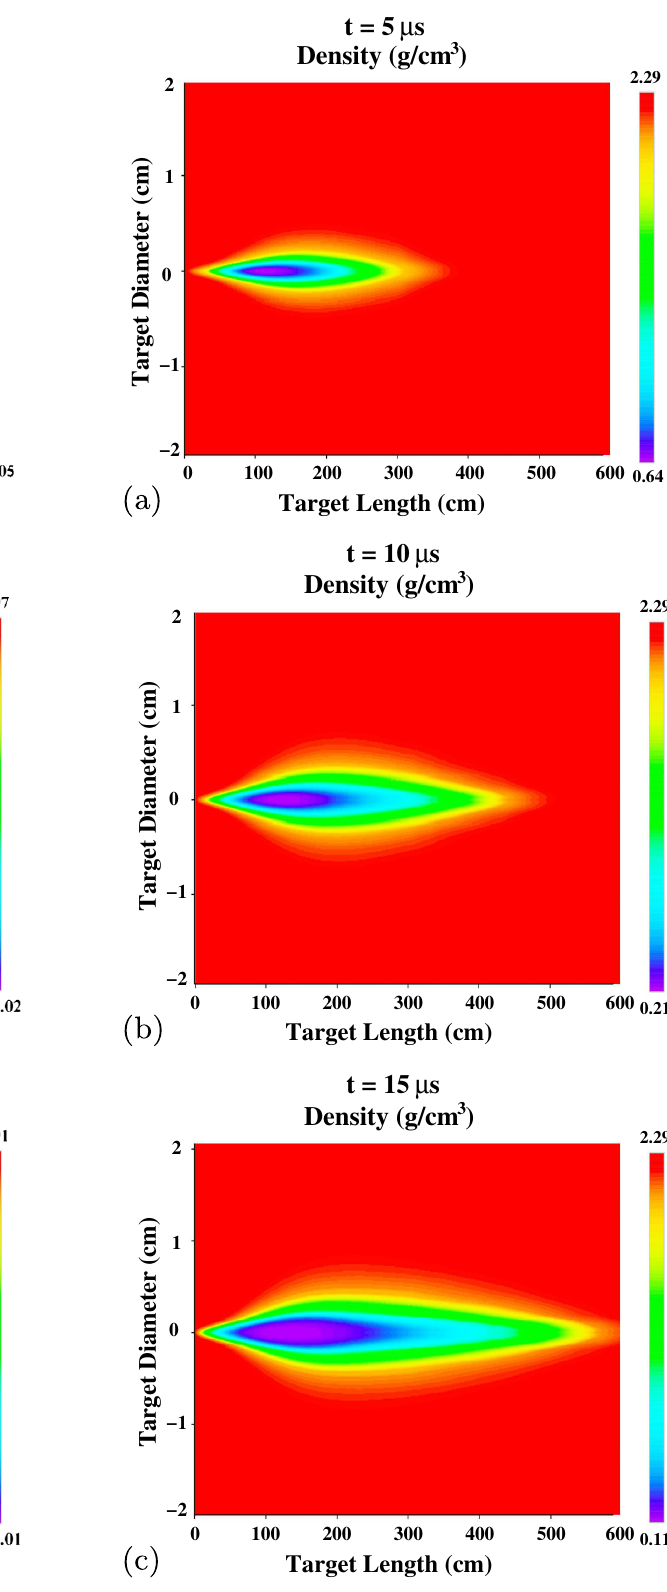
FIG. 7. Density distribution calculated by BIG2 in the carbon cylinder, r ¼ 5 cm , L ¼ 6 m , irradiated by the LHC beam at the left face; (a) at t ¼ 5 (cid:2) s ; (b) at t ¼ 10 (cid:2) s ; and (c) at t ¼ 15 (cid:2) s